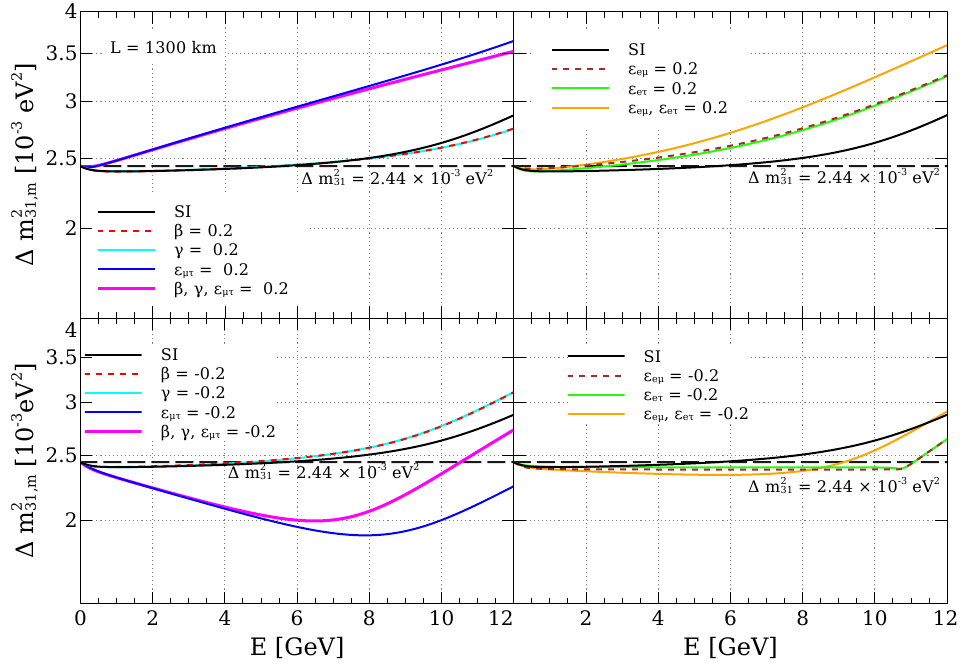
( ≡ m 2 ) as obtained from eqs. (5.1)–(5.3) is shown with Figure 6 . Variation of ∆ m 2 − m 2 31 ,m 3 ,m 1 ,m energy in SI case and SI+NSI cases. Top (bottom) row corresponds to the positive (negative) NSI with strength 0.2. The solid black curve in each panel shows the SI case while the other curves show the modification in presence of NSI. The left column depicts the presence of various NSI parameters in (2,3) block while the right shows the effect of ε and ε . We consider L = 1300 km and the eµ eτ values of the oscillation parameters used in this plot are taken from table 2. We assume θ = 45 ◦ 23 and